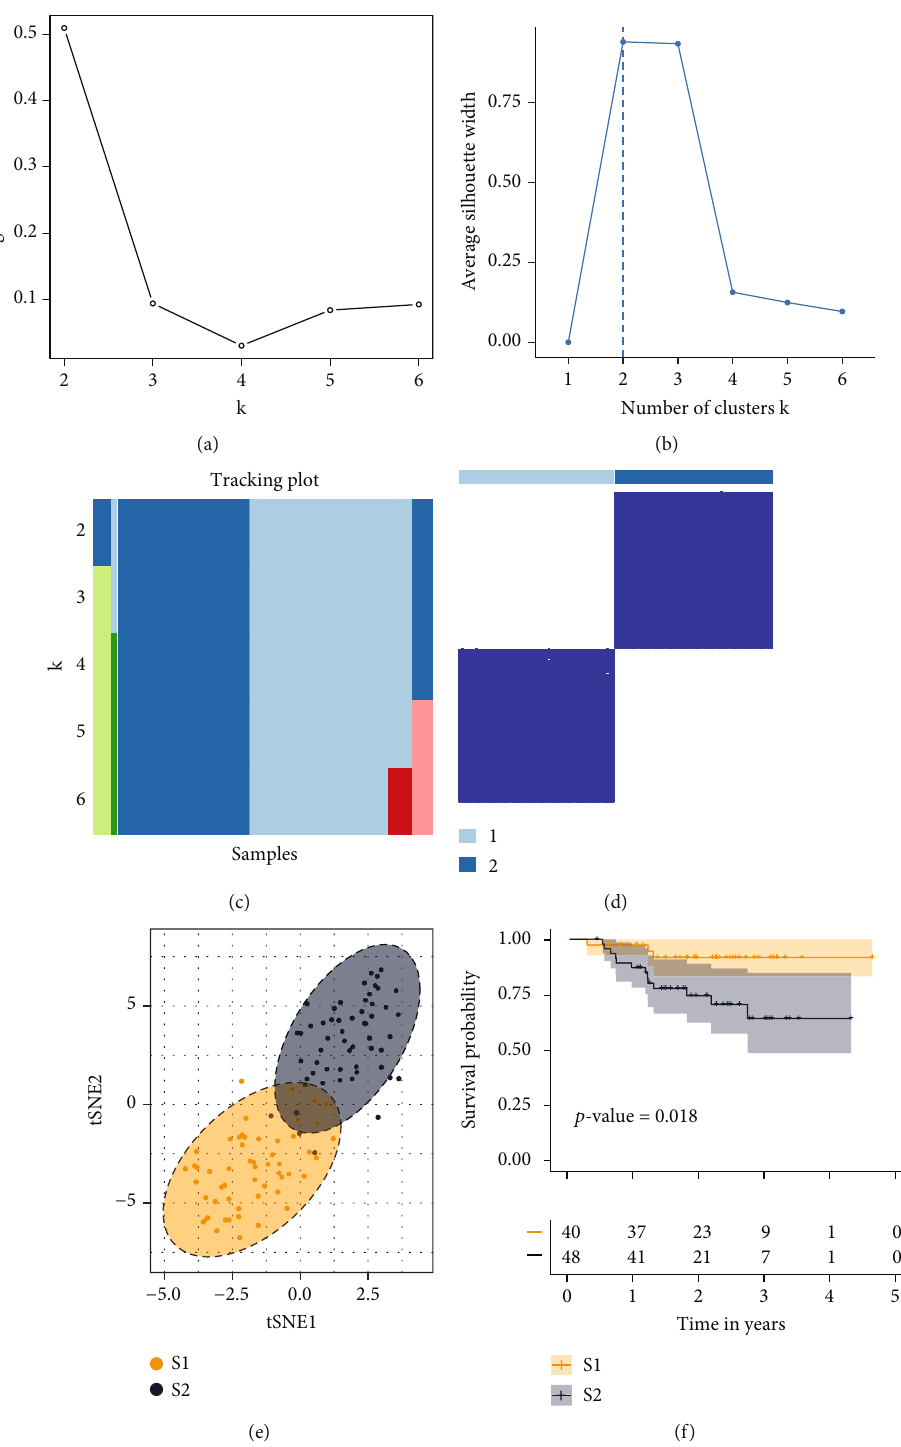
Figure 2: Consensus clustering for NPC samples from GSE102349. (a) The relative change in area under CDF curve for each k subtype. (b) Silhouette width of each subtype in NPC. The best subtype number was should be the k value with the highest value of average silhouette width. (c) In the tracking plot, the percentages of subtypes were indicated by di ff erent colors. (d) Consensus matrix heat map plots when k = 2 . (e) t-SNE-plot for RNA-sequencing data from NPC samples from GSE102349. (f) Five-year Kaplan-Meier curves for progression- free survival of NPC patients strati fi ed by the NPC subtypes. CDF: consensus clustering cumulative distribution